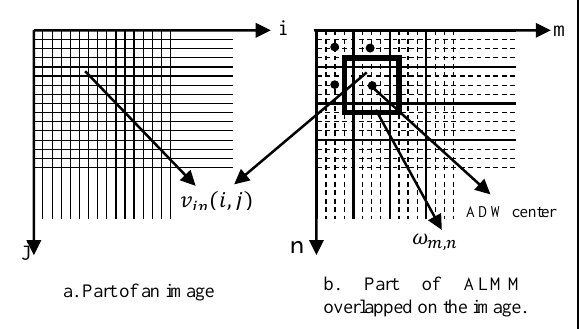
Fig.1 Image and its Local Mean